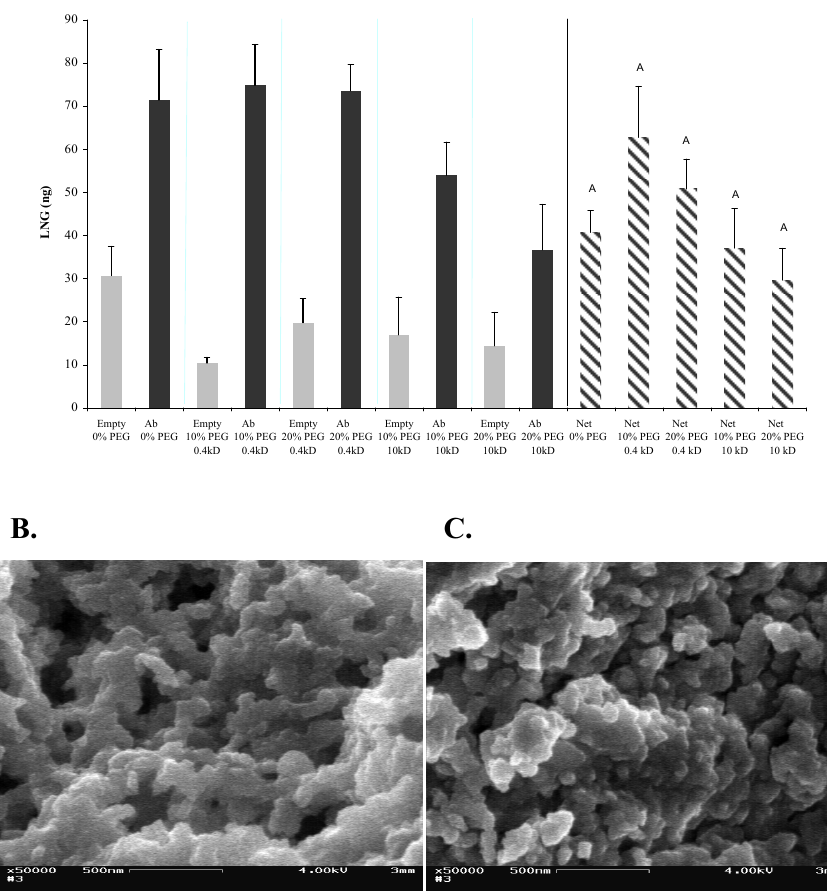
Figure 1. Effects of PEG on the structure and activity of entrapped Abs in 1:8-TMOS-based sol-gel. ( A ) LNG (100 ng) was applied on 1-day-aged sol-gel columns containing 0, 10 or 20% of 0.4-kDa or 10-kDa PEG. Amount of eluted LNG was determined by ELISA. Vertical bars labeled ‘Empty’ represent columns that were not doped with Abs, and therefore represent non-specific binding. Bars labeled ‘Ab’ represent the total binding capacity and bars labeled ‘Net’ represent the specific binding values (Ab minus empty). Each bar represents the mean  S.E.M of n experiments, where: for 0% PEG, n = 2; for 10 or 20% of 0.4-kDa PEG, n = 6; for 10 or 20% of 10-kDa PEG, n = 4. Means with the same letter did not differ significantly at p < 0.05; ( B ) SEM image of 1:8 TMOS-based sol-gel containing 0% PEG; ( C ) SEM image of 1:8 TMOS-based sol-gel containing 10% of 0.4-kDa PEG. Magnification, ×50,000; scale bar represents 500 nm.